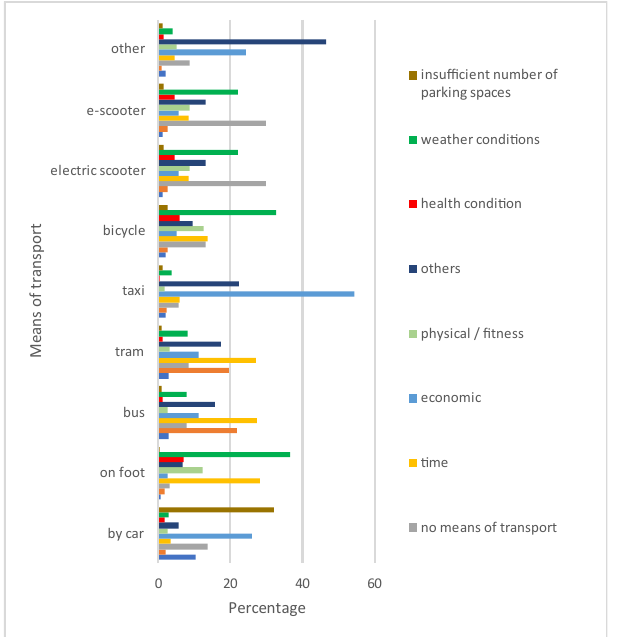
Figure 19. Accessibility: limitations to the surveyed means of transport, as indicated by the respondents.